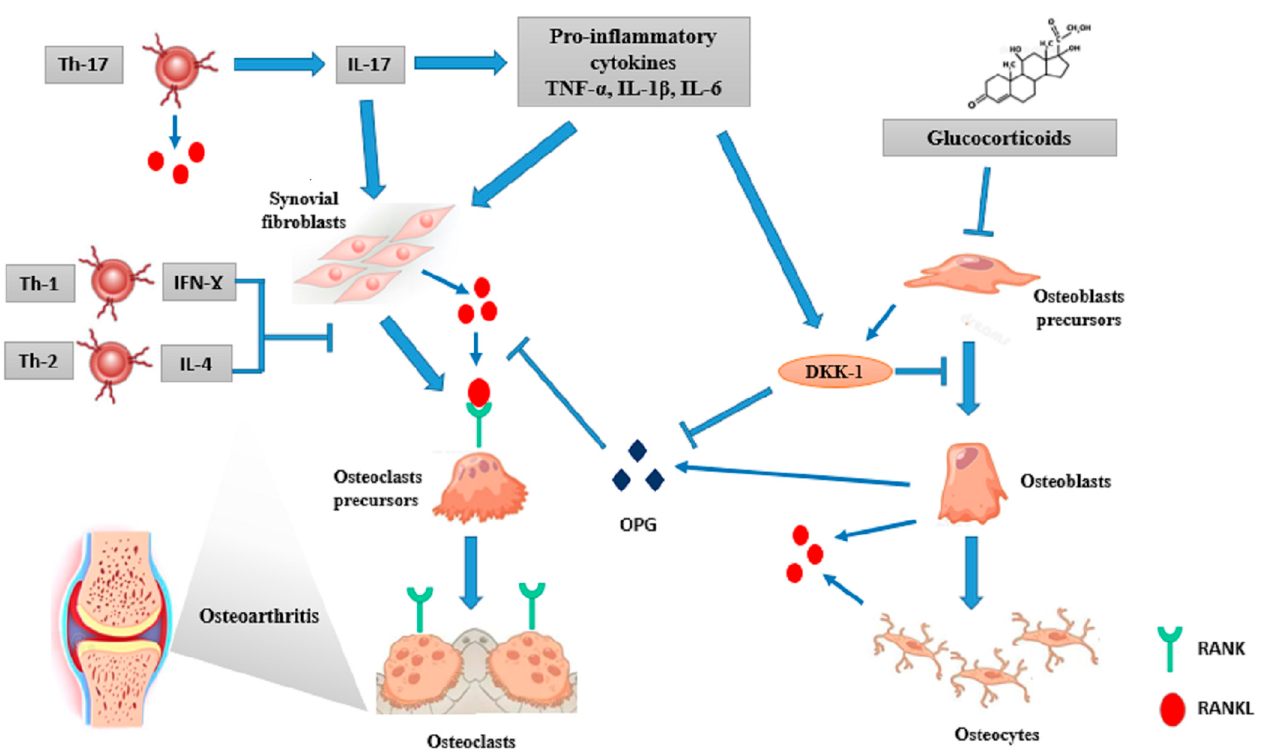
Figure 2. The role of inflammation on bone metabolism.